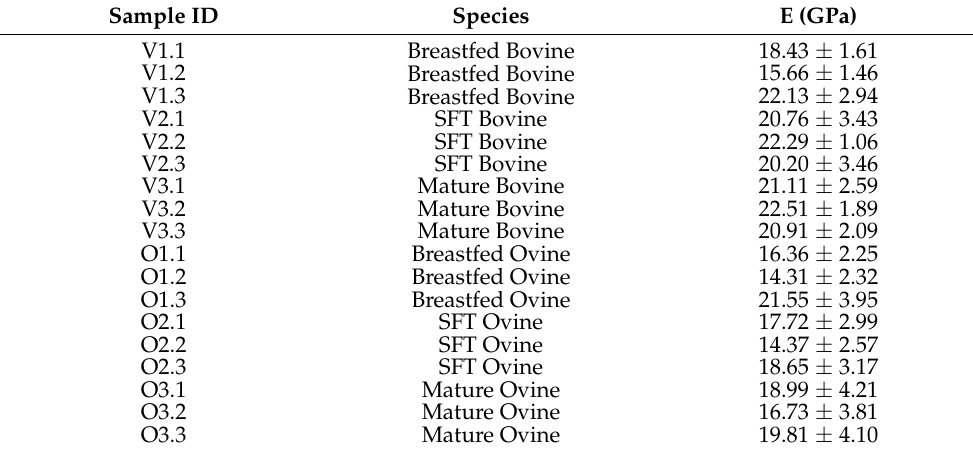
Table 3. Results of the nanoindentation tests for each evaluated sample. SFT refers to solid-food transitioning specimens.